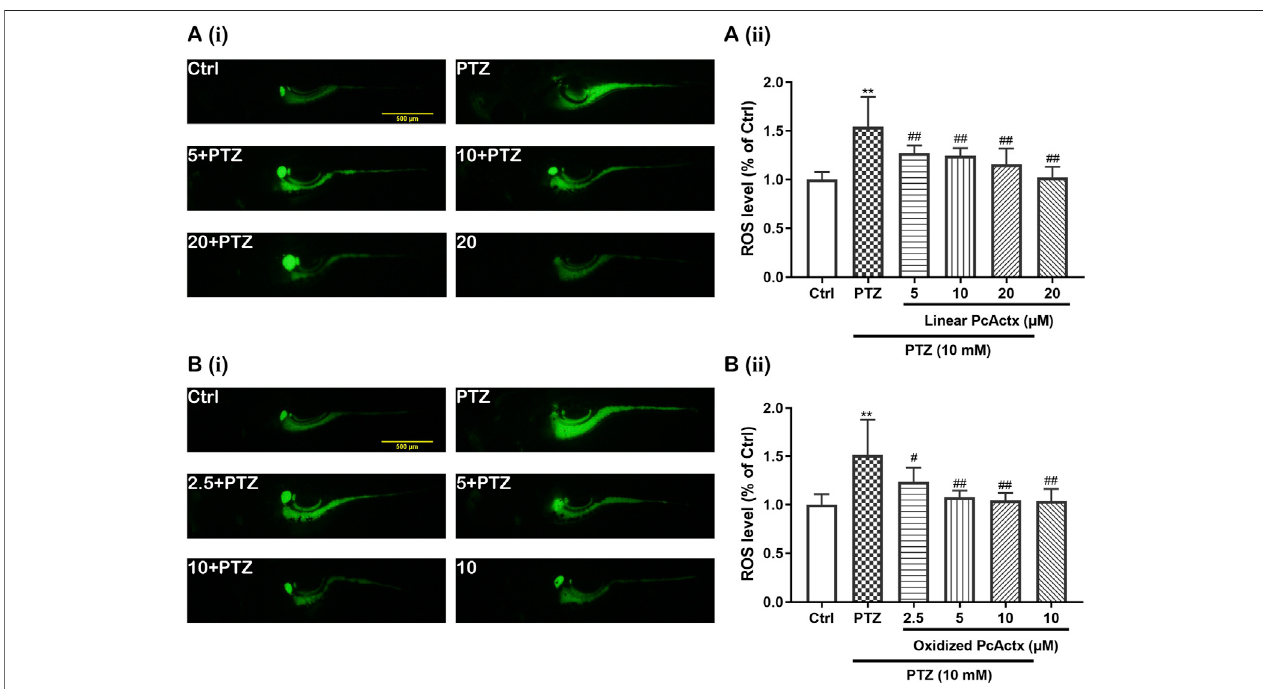
FIGURE 9 | PcActx peptides attenuated PTZ-induced accumulation of ROS in zebra fi sh larvae. (A) . Linear PcActx peptide. (B) . Oxidized PcActx peptide. (i). Representativemicrographsof fl uorescence.(ii).StatisticalanalysisofROSproduction.Dataareexpressedasmeans ± SD(n (cid:2) 6 – 8).* p < 0.05vsCtrlgroup,** p < 0.01 vs Ctrl group, # p < 0.05 vs PTZ group, ## p < 0.01 vs PTZ